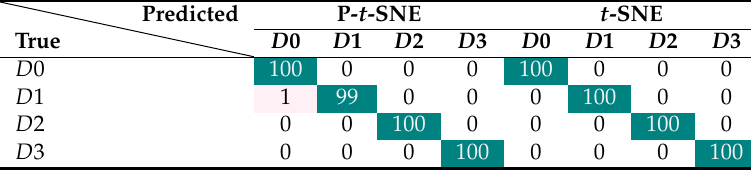
Table 7. Accuracy, PPV, TPR, F 1 score, and TNR of the application of P- t -SNE and t -SNE damage detection and classification method presented in Sections 3 and 4: scenario 2 and the majority voting approach. P- t -SNE t -SNE Accuracy 99.8%